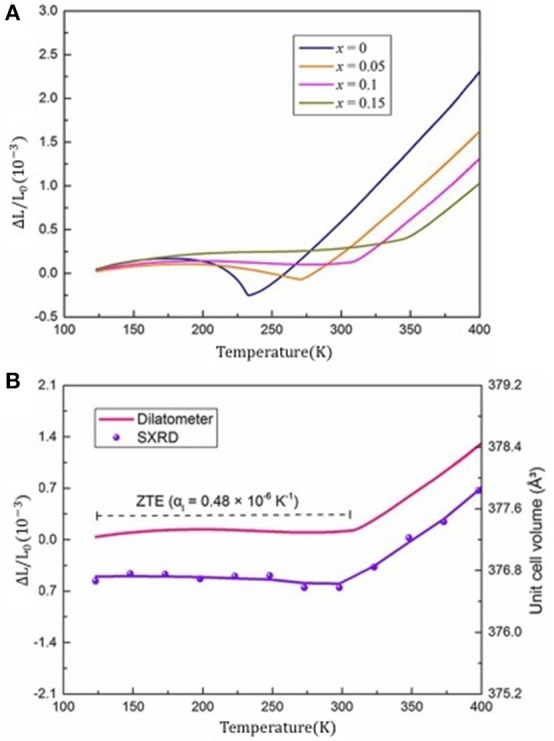
(A) Temperature dependent linear thermal expansion (ΔL/L0) of Tb(Co2−xFex). (B) The ZTE in the TbCo1.9Fe0.1 measured by both dilatometer and SXRD. Reprinted with permission from (Song et al., 2018). Copyright 2018, ACS Publishing Limited.